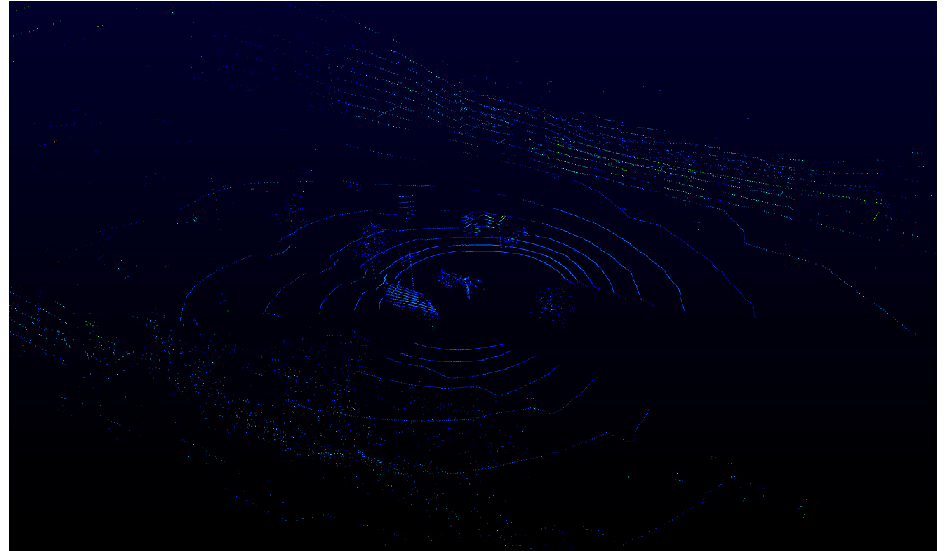
Figure 1. An example of the point cloud collected from an urban environment by an autonomous car using a Velodyne VLP-16 sensor (Velodyne LIDAR, San Jose, California, USA). A wall of a nearby building, a passing vehicle and city trees can be observed from the sample point cloud. By 2030, such data will be collected by several sensors in each car, and such cars are provided with more than 10 M units per year.